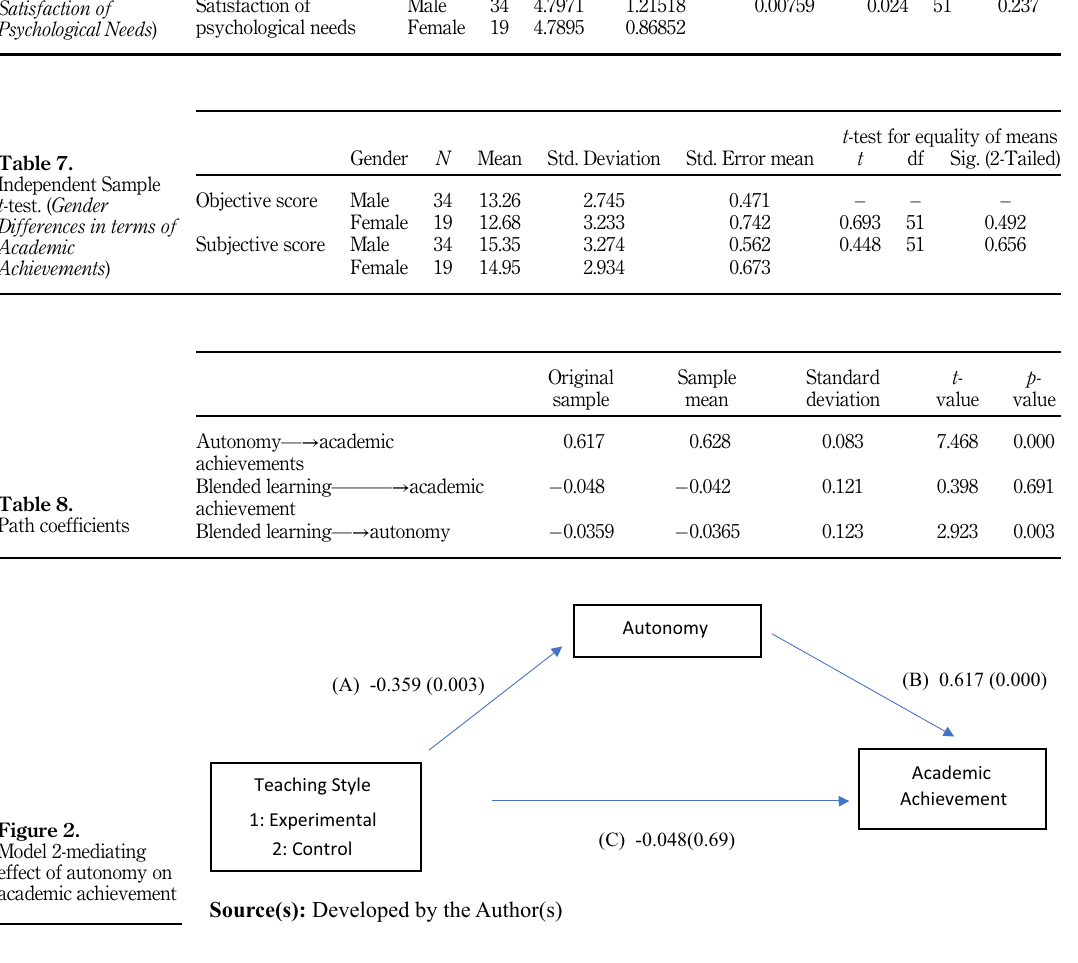
t -test. ( Gender Differences in terms of Satisfaction of Psychological Needs )